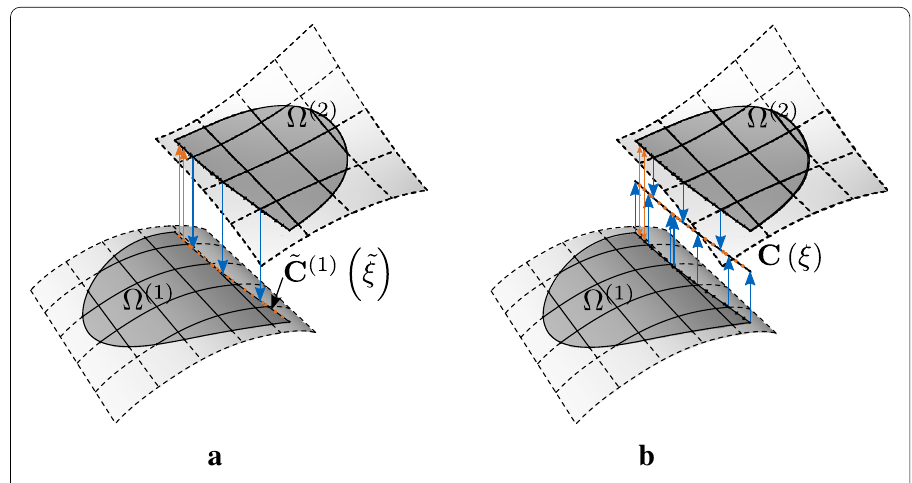
a b Fig. 8 Derivation of the integration points for the coupling domain. The intersecting knot lines from master and slave patch are mapped to the respective coupling curve, the integration domain is derived as for a classic curve, e.g. by Gauss points, and those integration points are mapped back onto the patches. a Trimming curve of the master patch is the coupling curve. b Geometry curve is the coupling curve as also described in